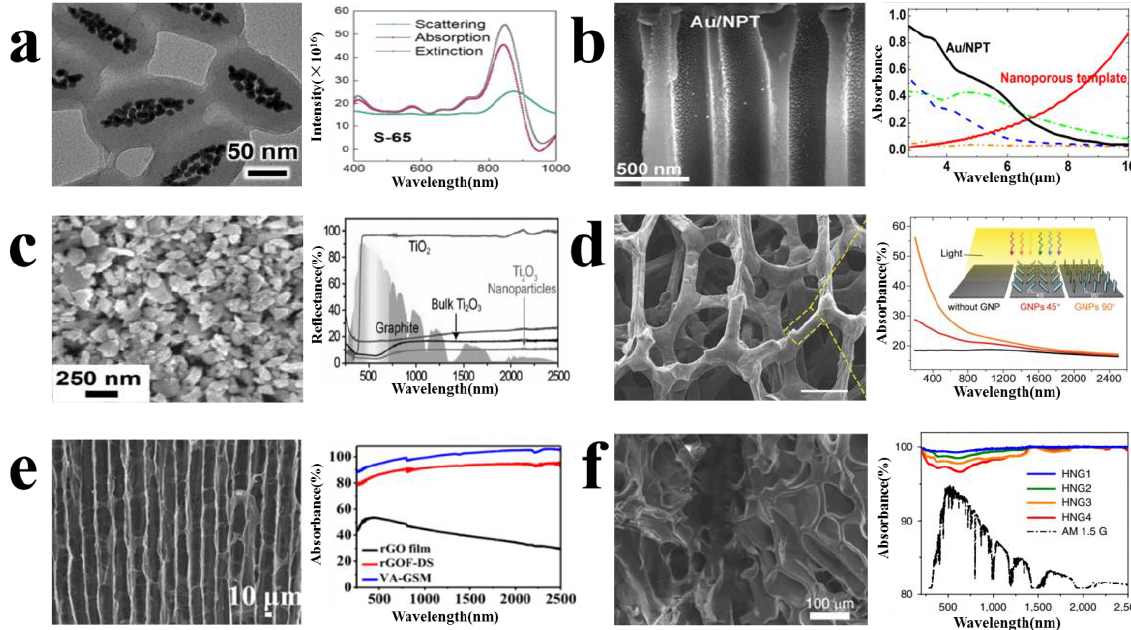
Figure 3: SEM images and absorption spectra of: (a) AgNPs assemblages [62]; (b) self-assembled AuNPs [39]; (c) narrow bandgap Ti2O3 [52]; (d) h-G foam [41], (e) VA-GSM [60]; (f) HNGs